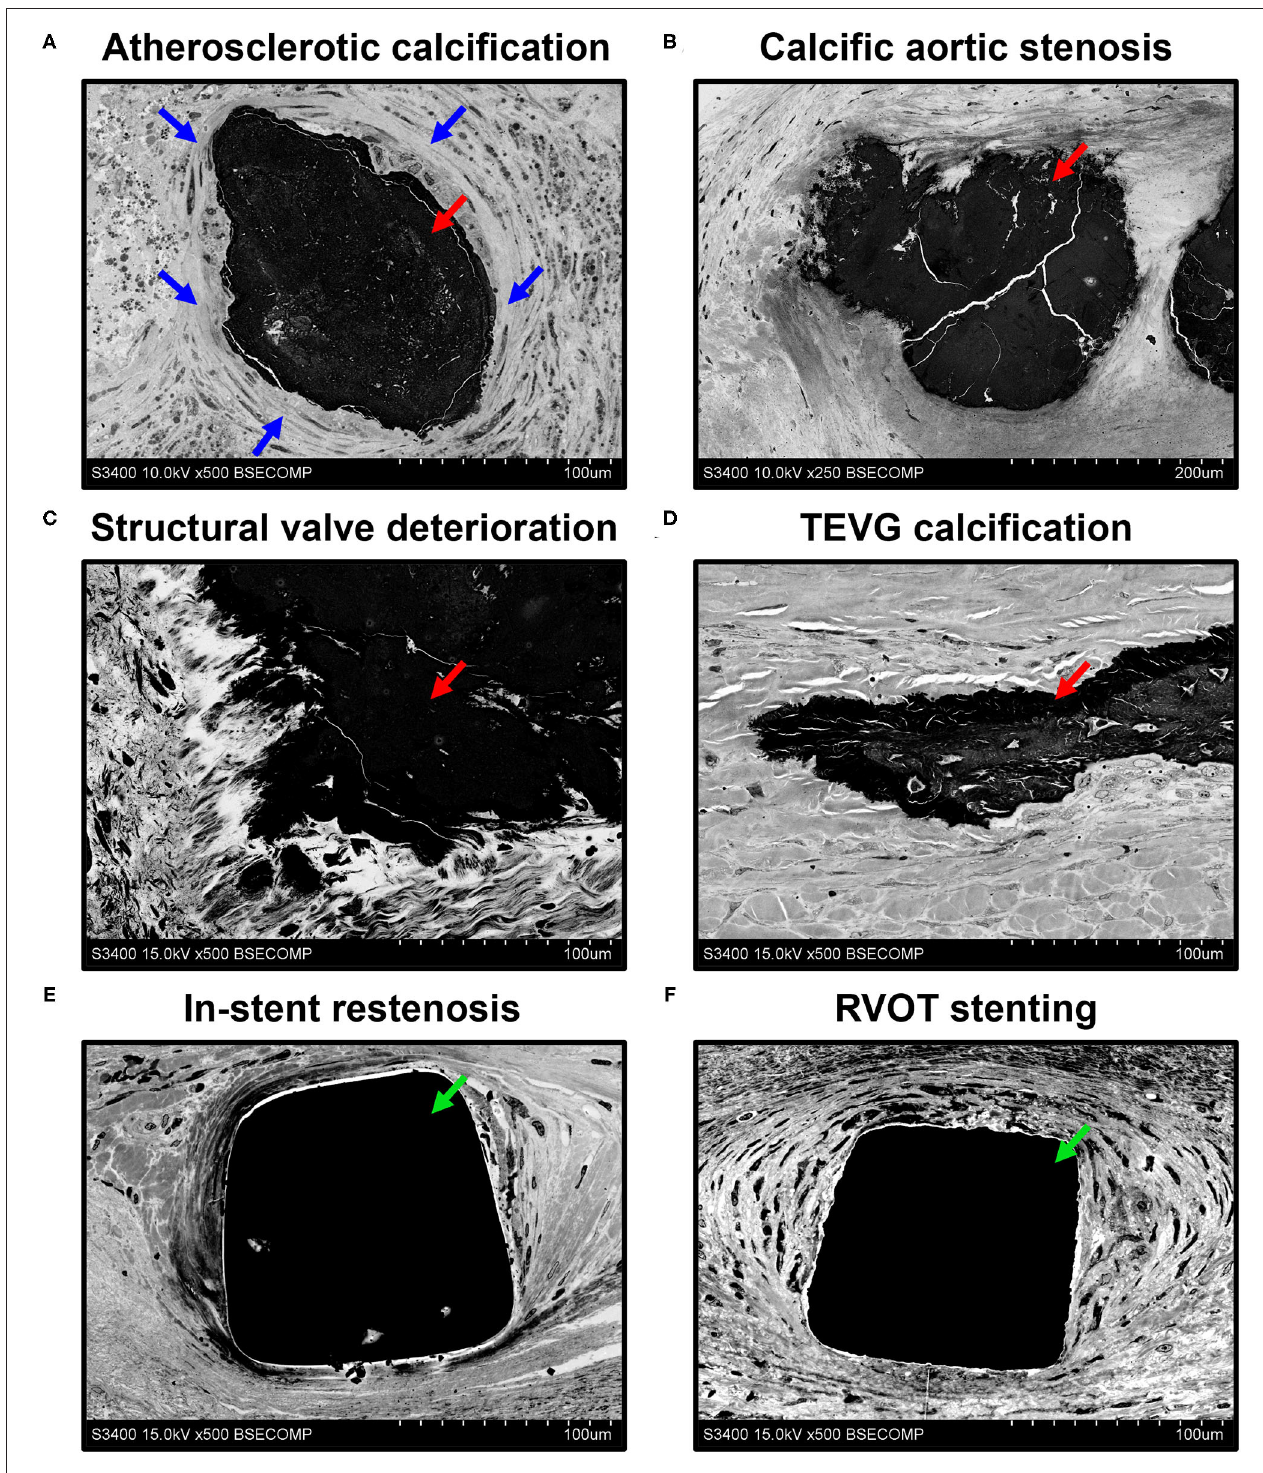
FIGURE 5 | Visualisation of mineral deposits (indicated by red arrows) and metal implants (indicated by green arrows) in cardiovascular tissue by EM-BSEM shows the retained integrity of calcified [carotid plaque (A) , native (B) , and bioprosthetic (C) aortic valves, and tissue-engineered vascular grafts implanted into the ovine carotid artery (D) ] and metal-incorporating tissues [human carotid artery (E) and right ventricular outflow tract (F) ]. Note the clear-cut connective tissue capsule (indicated by blue arrows) around the atherosclerotic but not the valvular or vascular graft calcifications. A magnification of × 500 (scale bar: 100 µ m) for all images, except that of the calcified native aortic valve ( × 250 magnification, scale bar: 200 µ m). The accelerating voltage was 15 kV for all images, except those of the atherosclerotic plaque and calcified native aortic valve (10 kV).